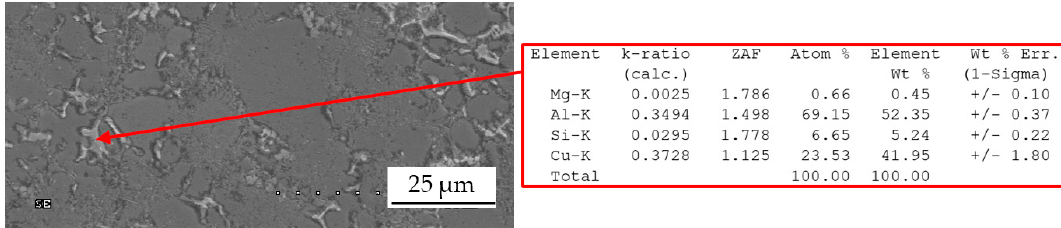
Figure 7. Results of the point analysis of the chemical composition of the intermetallic phase in the microstructure of HPDC EN AC-46000 alloy. The arrow indicates the phase under analysis.